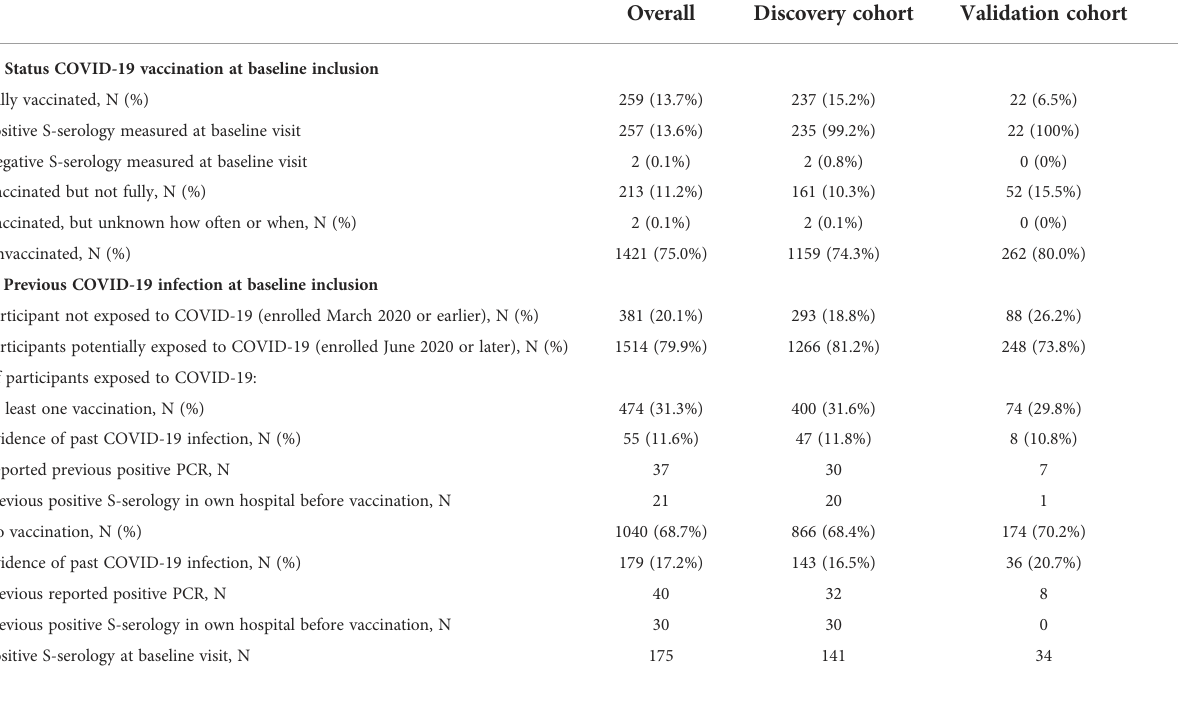
TABLE 6 COVID-19 status and serology measurement at baseline